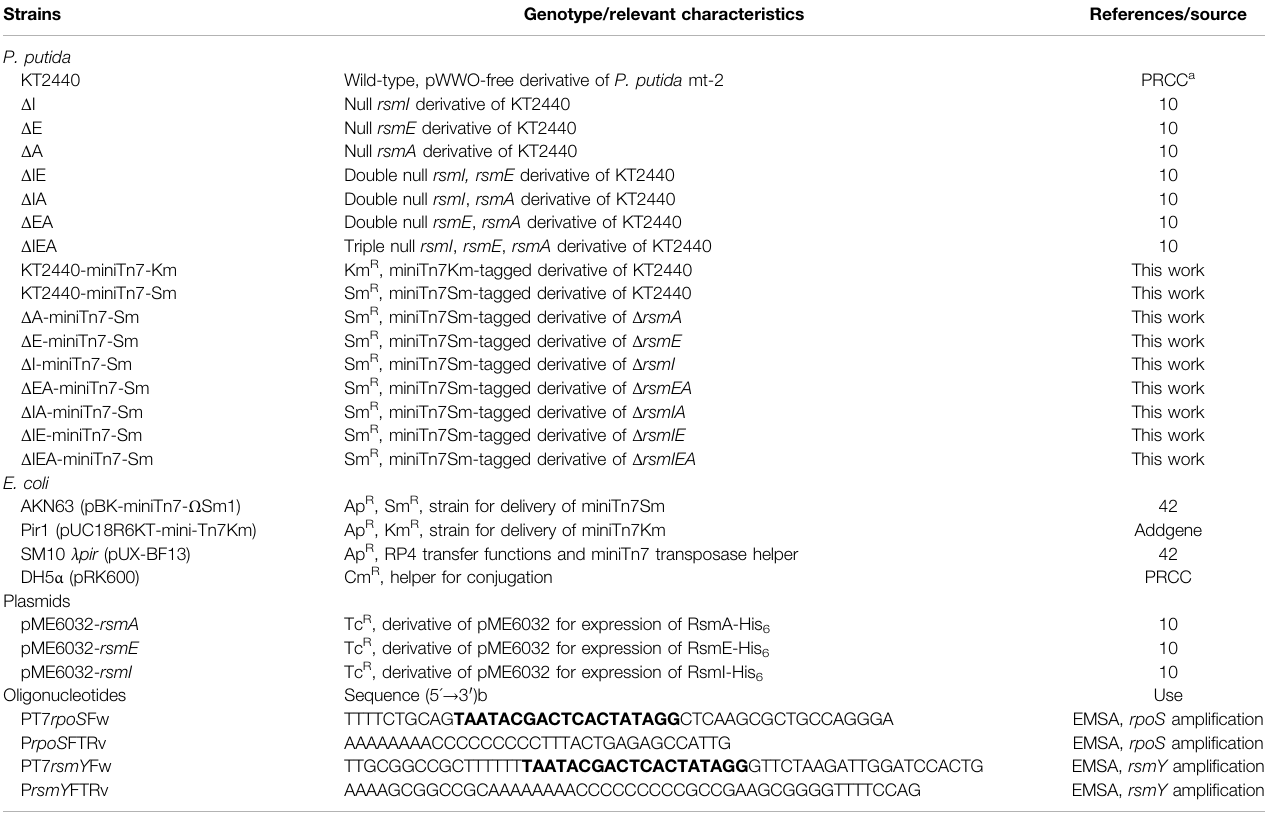
TABLE 1 | Bacterial strains, plasmids and oligonucleotides used in this work.